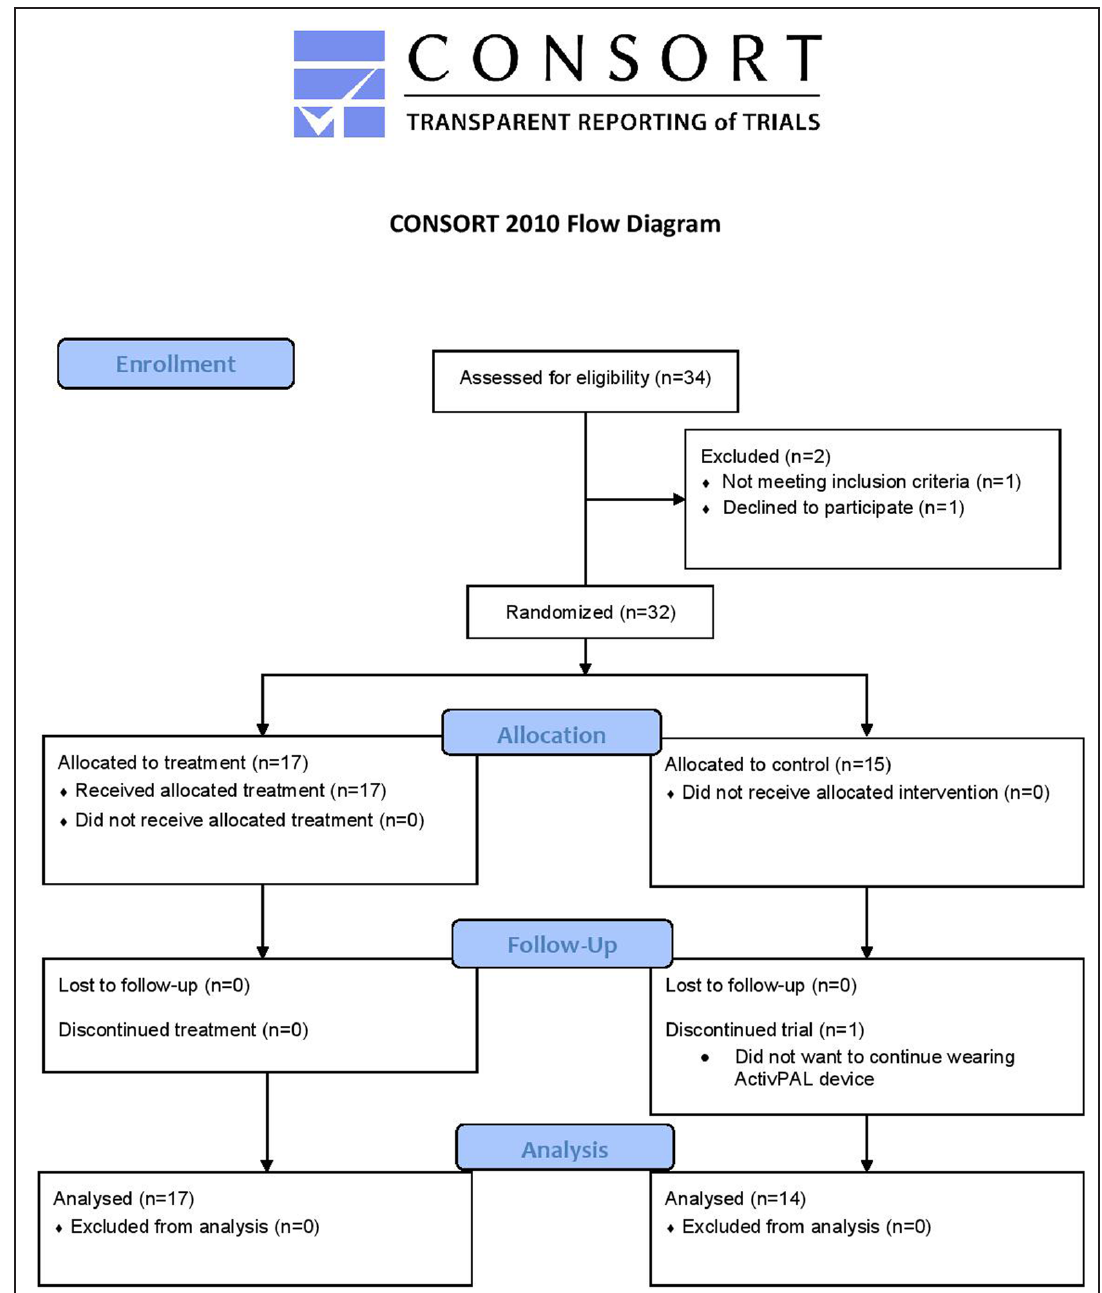
Figure 1 Flow of participants through the